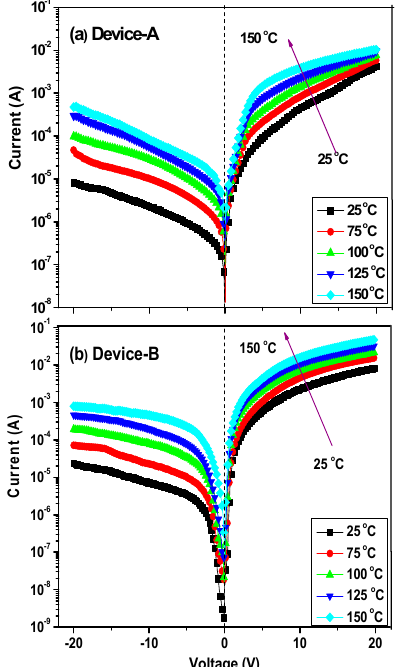
Figure 5. Forward and reverse ( I – V ) characteristics of ( a ) device-A and ( b ) device-B tested in the temperature range of 25 – 150 °C.